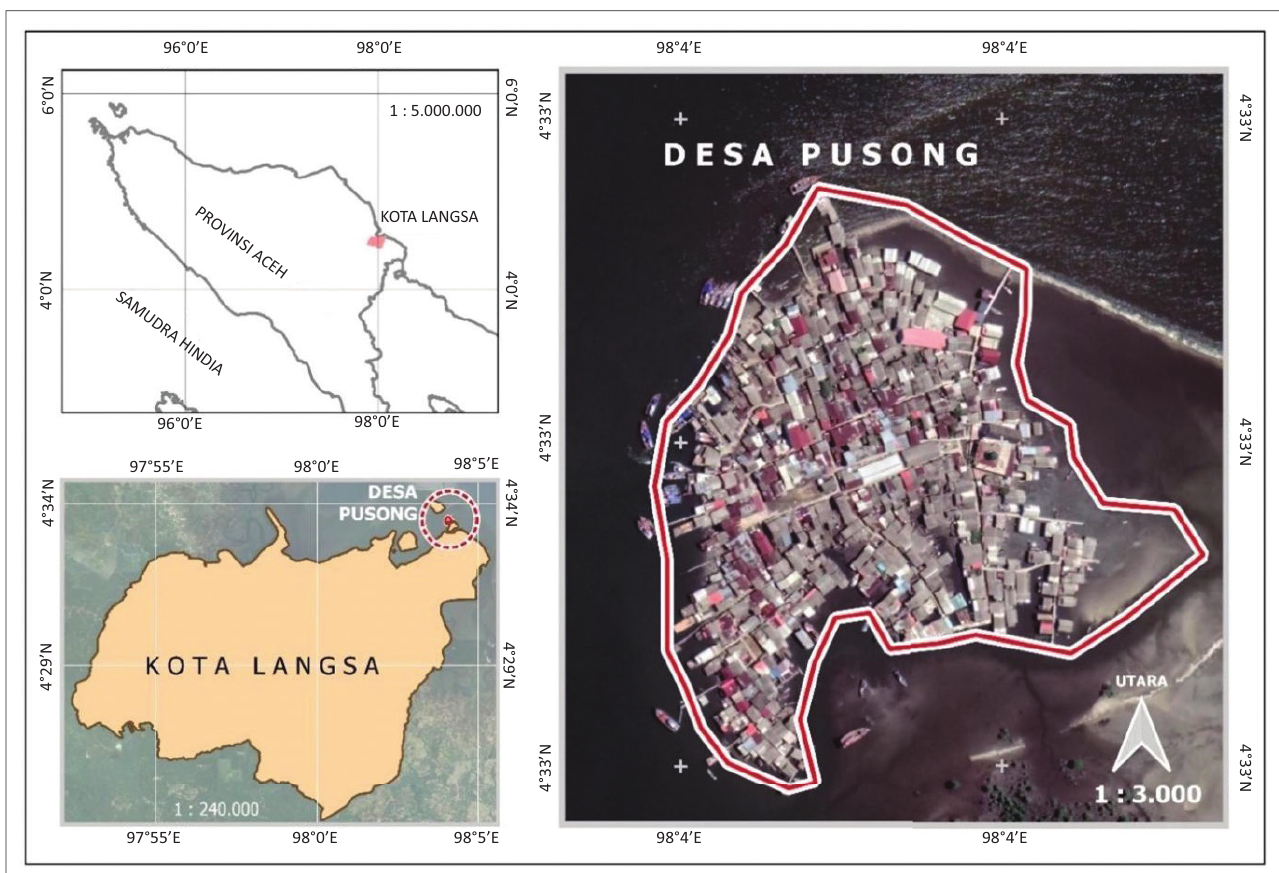
FIGURE 2: Pusong Village, West Langsa Sub-district.